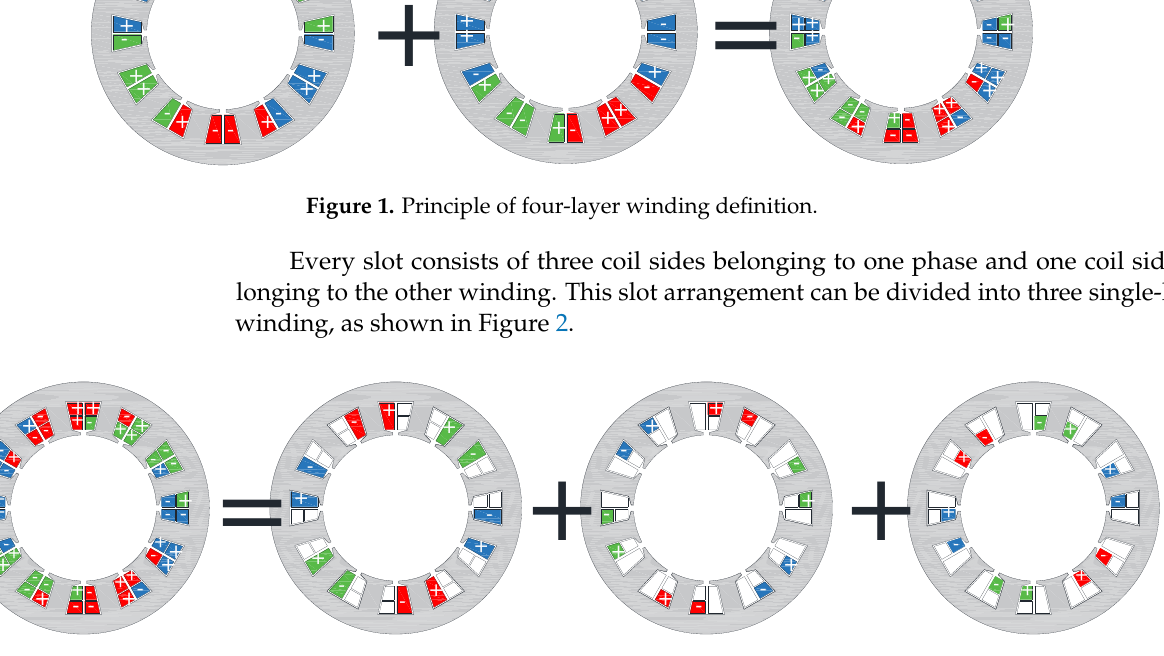
Figure 2. Decomposition of four-layer winding to three single-layer windings. Identical configuration of every single-layer winding can be obtained by two different windings: (a) fractional slot winding q = 2/5 with 10 poles; (b) integer slot winding q = 2 with 2